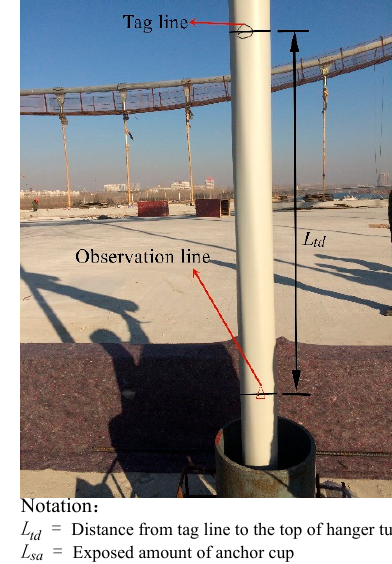
Notation ： L = Distance from tag line to the top of hanger tube td L sa = Exposed amount of anchor cup L ta = Distance from tag line to the bottom of anchor cup L c = Distance from cable center to hanger fork ear center L s = Unstressed length of hanger